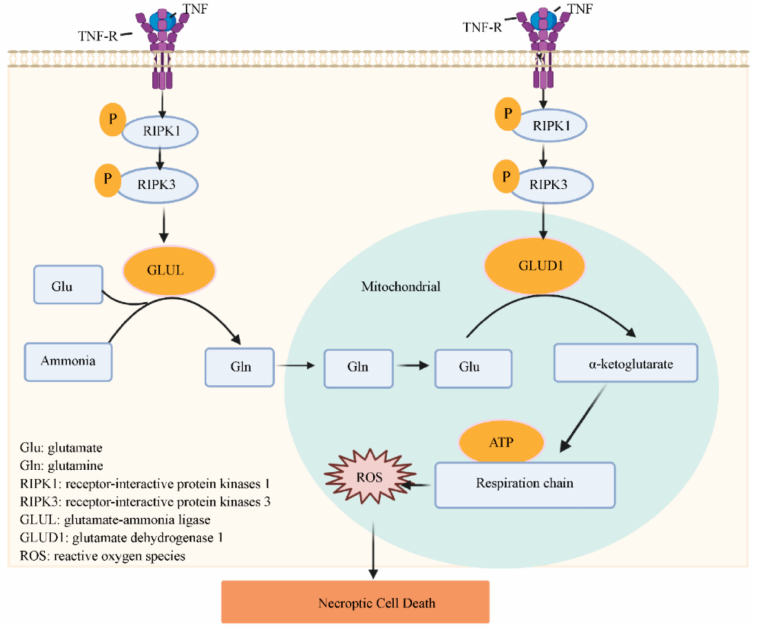
Figure 2. The role of metabolic enzymes of mitochondria in necroptosis. Endogenous RIPK3 can directly increase glutamate-ammonia ligase (GLUL) and glutamate dehydrogenase 1 (GLUD1) activity. GLUL is a cytosolic enzyme that catalyzes the condensation of glutamate and ammonia to form glutamine. Glutamine can translocate into the mitochondria to function as an energy substrate. GLUD1 is a mitochondrial matrix enzyme that converts glutamate to α -ketoglutarate. GLUL and GLUD1-mediated uses of glutamate or glutamine as energy substrates contribute to